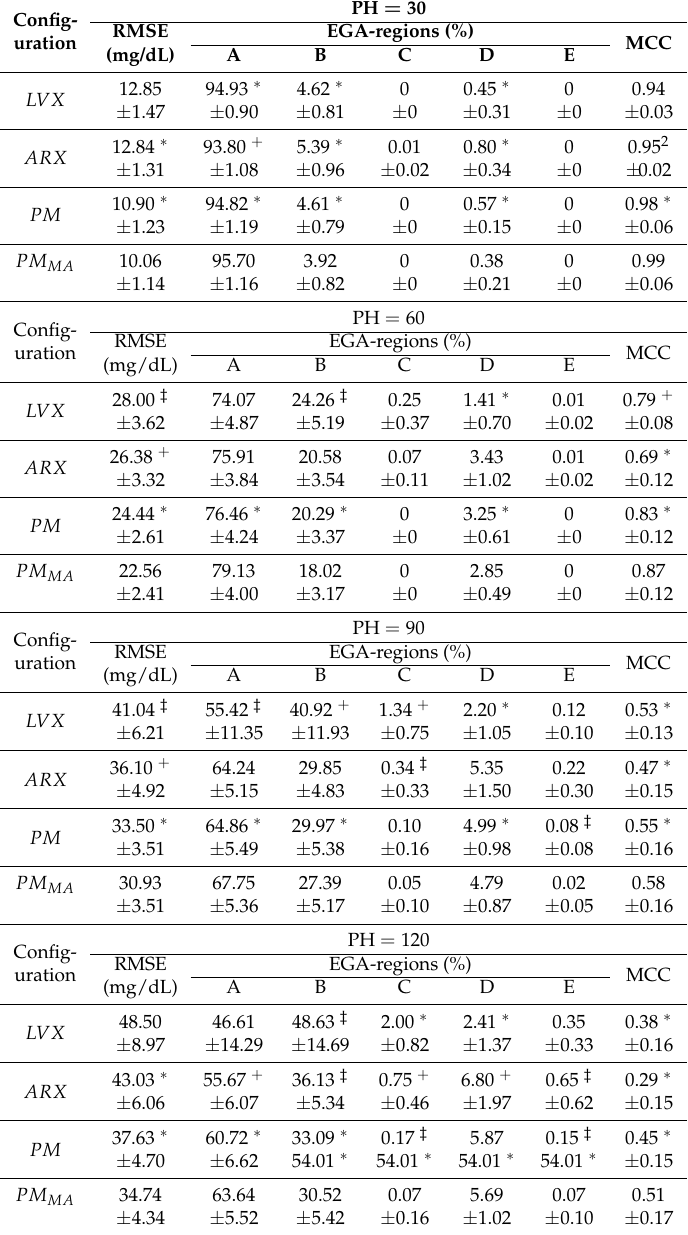
Table 3. Results corresponding to the 10-adult virtual population expressed as Mean ± STD for the studies algorithms and different PH in minutes. Assessment of statistical significance between adjacent rows is indicated with ∗ for p < 0.001, + for p < 0.01 and ‡ for p < 0.05.